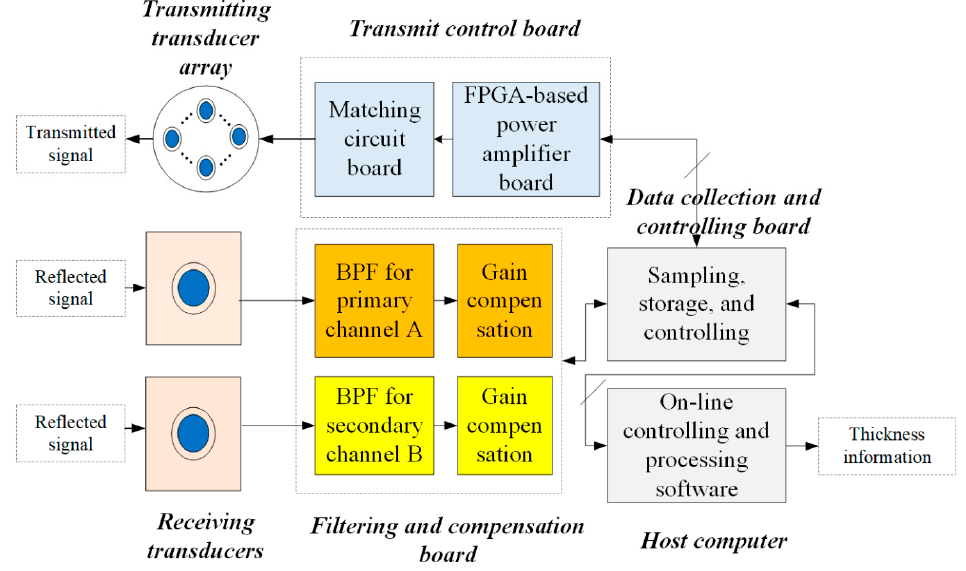
Figure 1. System description of PPPAAP17.